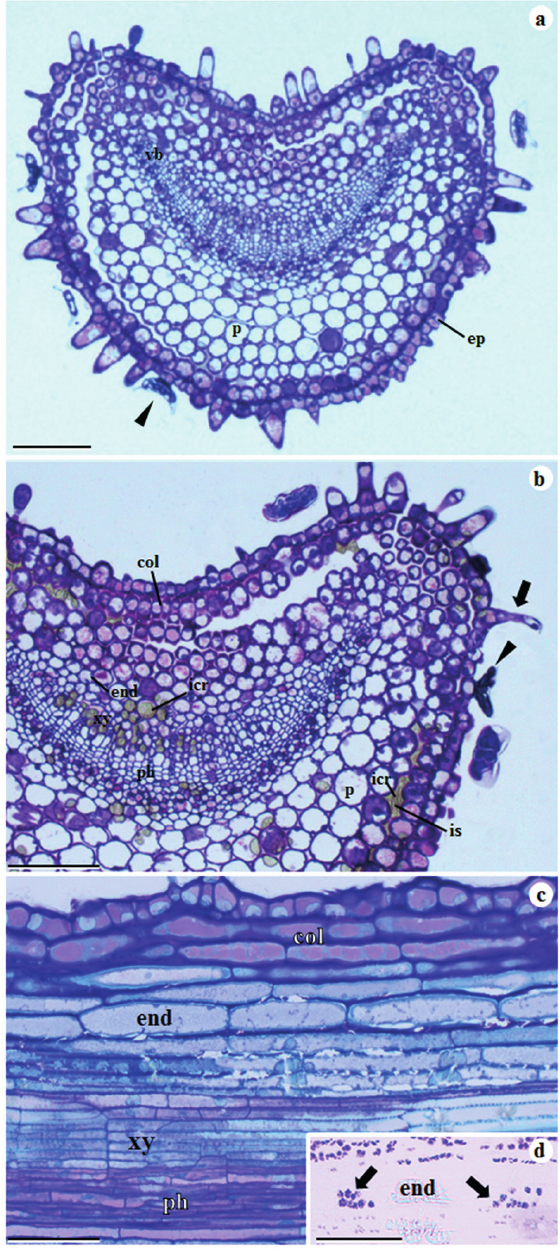
Figure 2 - Structural characterization of Hesperozygis ringens leaf petiole. Figures 2a-b in transversal sections. Figures 2c-d in longitudinal section. (a) Epidermis (ep), parenchyma (p) and vascular bundle (vb). (b) Non-glandular trichome (arrow), glandular trichome (arrow head), collenchyma (col), endodermis (end), inulin crystals (icr), xylem (xy), phloem (ph), parenchyma (p) and intercellular space (is). (c) Detail of collenchyma (col), endodermis (end), xylem (xy) and phloem (ph). (d) Detail of starch (black arrow) in endodermis (end) after reaction with lugol. Scale bars: 50 µm (d) ; 100 µm (a, b and c)